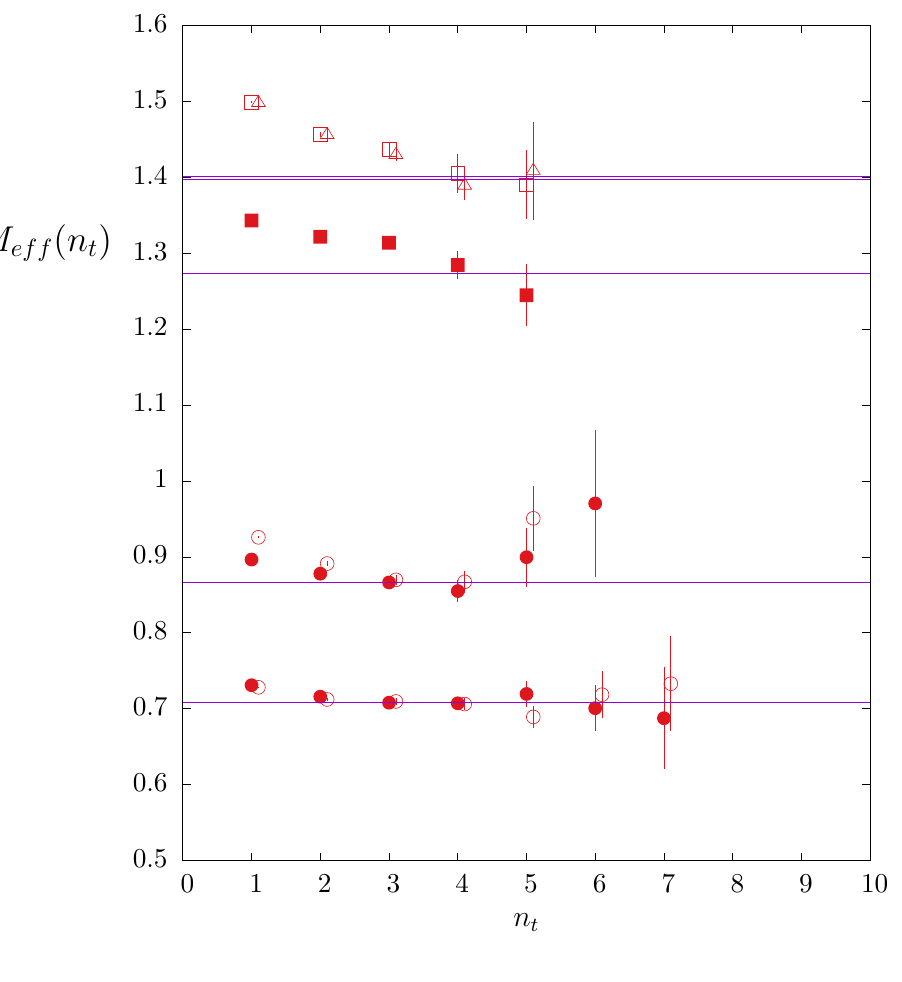
Figure 3 . E(cid:11)ective masses of the lightest and (cid:12)rst excited J P = 2 + ( (cid:15) ) and J P = 2 (cid:0) ( (cid:14) ) glueballs and the ground state J P = 0 (cid:0) ( (cid:4) ), J P = 1 (cid:0) ( (cid:3) ) and J P = 1 + ( M ) glueballs, all in SO(12) at (cid:12) = 250. The 0 (cid:0) and 1 (cid:6) values have been shifted by +0 : 4 for clarity. Lines are mass